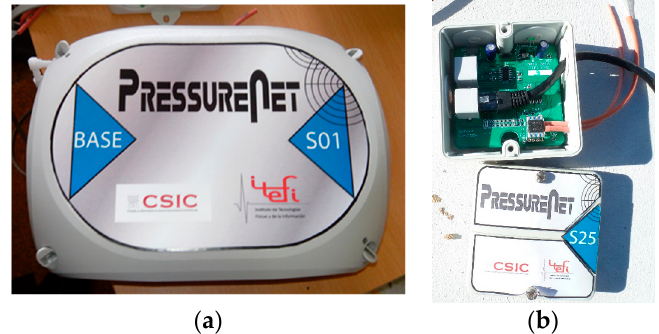
Figure 1. The PressureNet system developed by the authors ( a ) The multiplexer card (TMUX) card and ( b ) the modules for pressure sensors (MSP) pressure sensor.